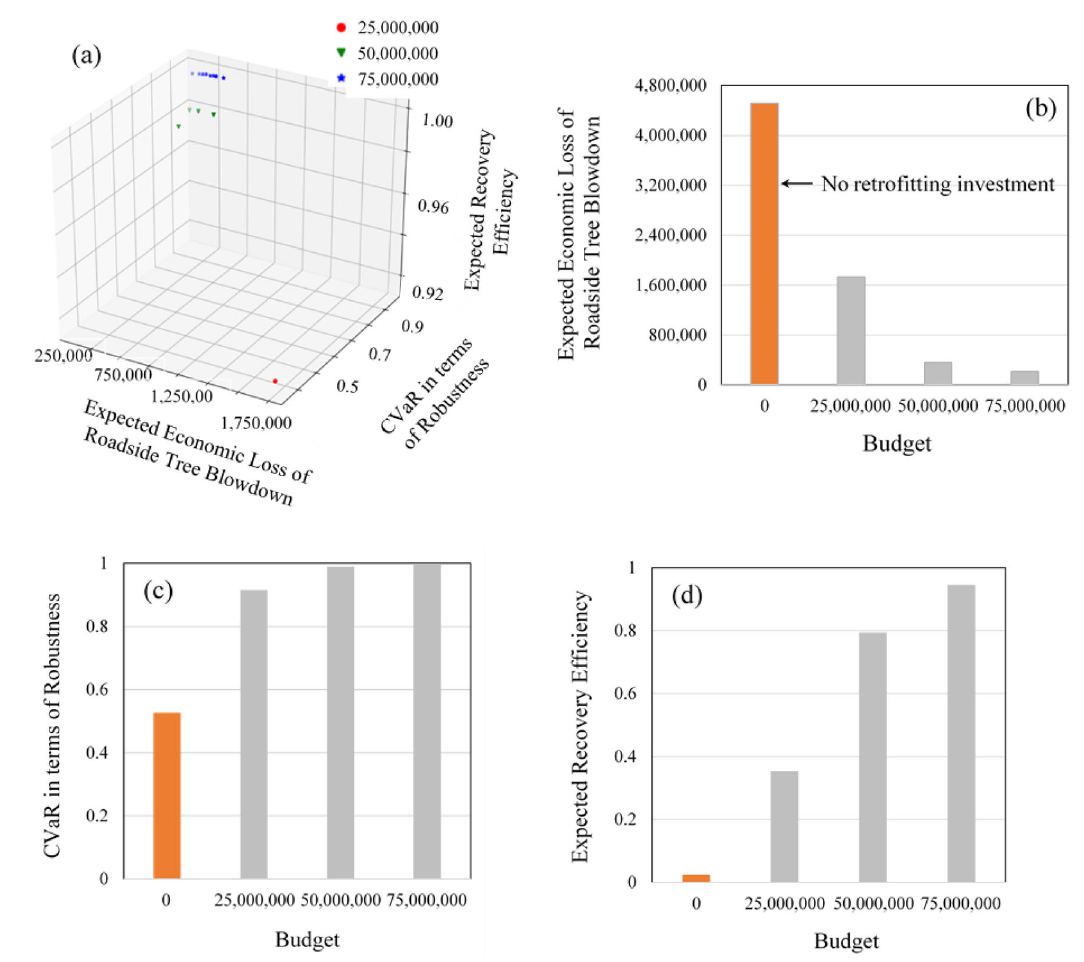
Fig. 8 Retrofit schemes comparison. ) The optimal nondominated solutions for retrofit schemes subject to three pre-set budgets. b – d are the mean values of expected economic loss of roadside tree